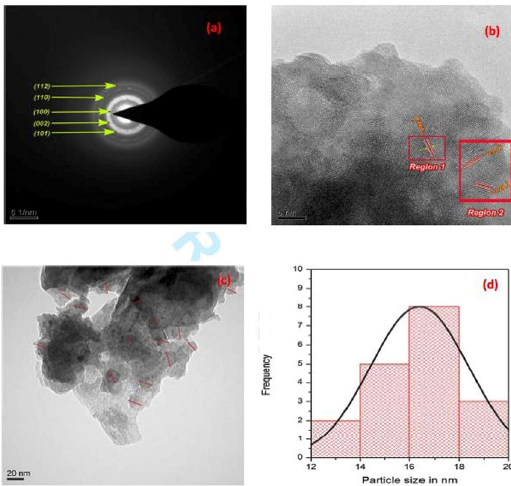
Figure 3. (a) Selected area electron diffraction (SAED) image of ZnS ; (b) HRTEM image showing inter-planar distances d